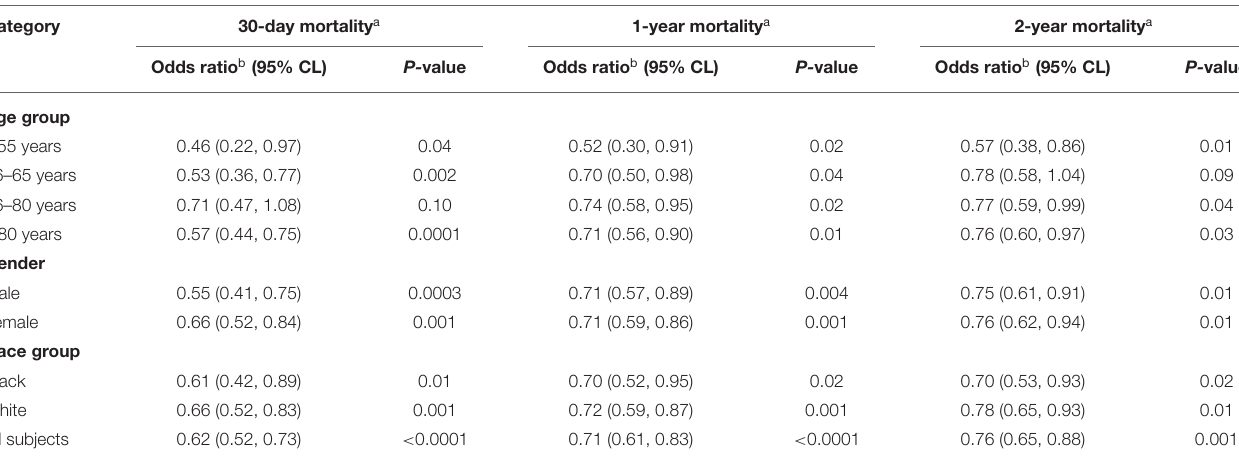
TABLE 4 | Results from stratified analyses of adjusted odds